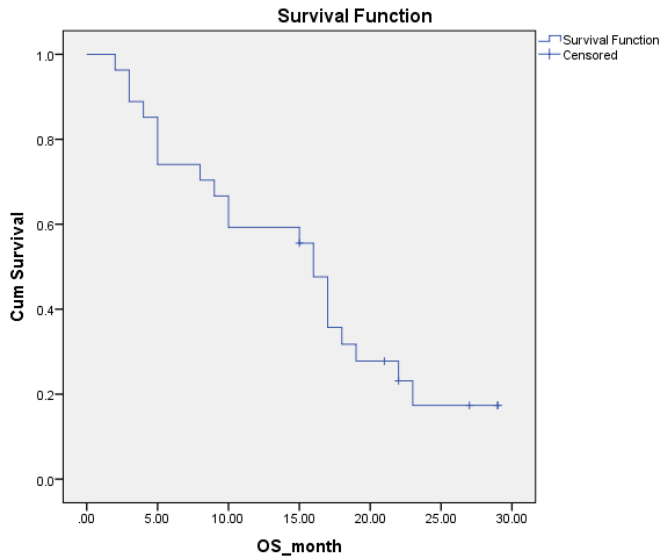
Figure 2. Kaplan – Meier curve of overall survival (n =